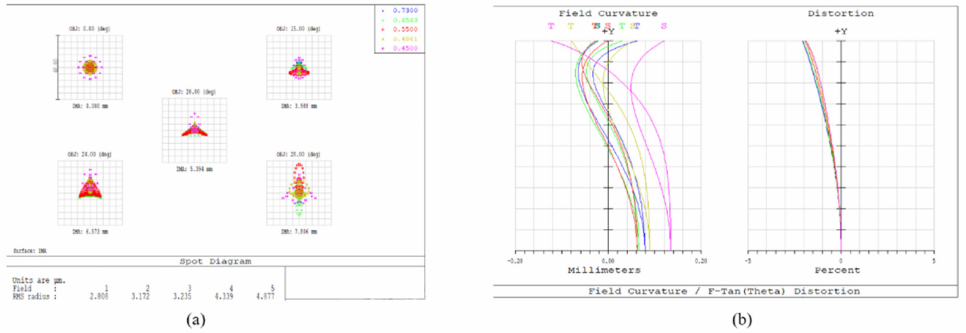
Figure 8. Wide-field optical system spot diagram together with field curvature and distortion. ( a ) Spot diagram; ( b ) field curvature and